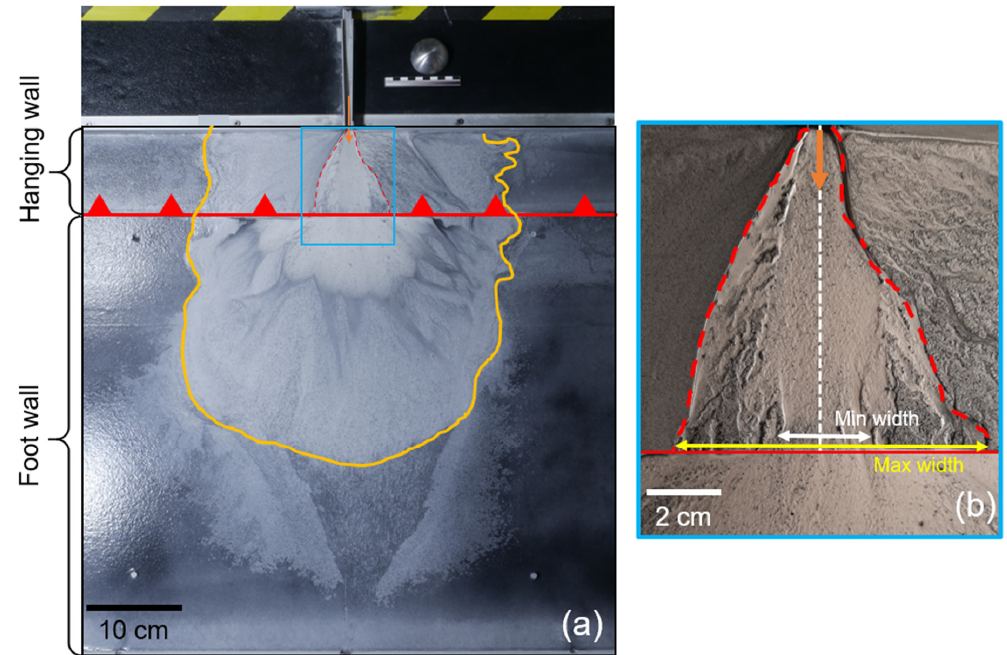
Figure 6. Final stage of an analog experiment. ( a ) General view. The reverse fault is outlined with a red line and triangles, and the contour of the alluvial fan appears in orange. The central valley is limited by red dashed lines and the flux entry with an orange arrow. ( b ) Close-up picture of the central valley. The minimum width outlined by a white arrow is the area where the flux is active. The maximum width includes old, abandoned river channels.